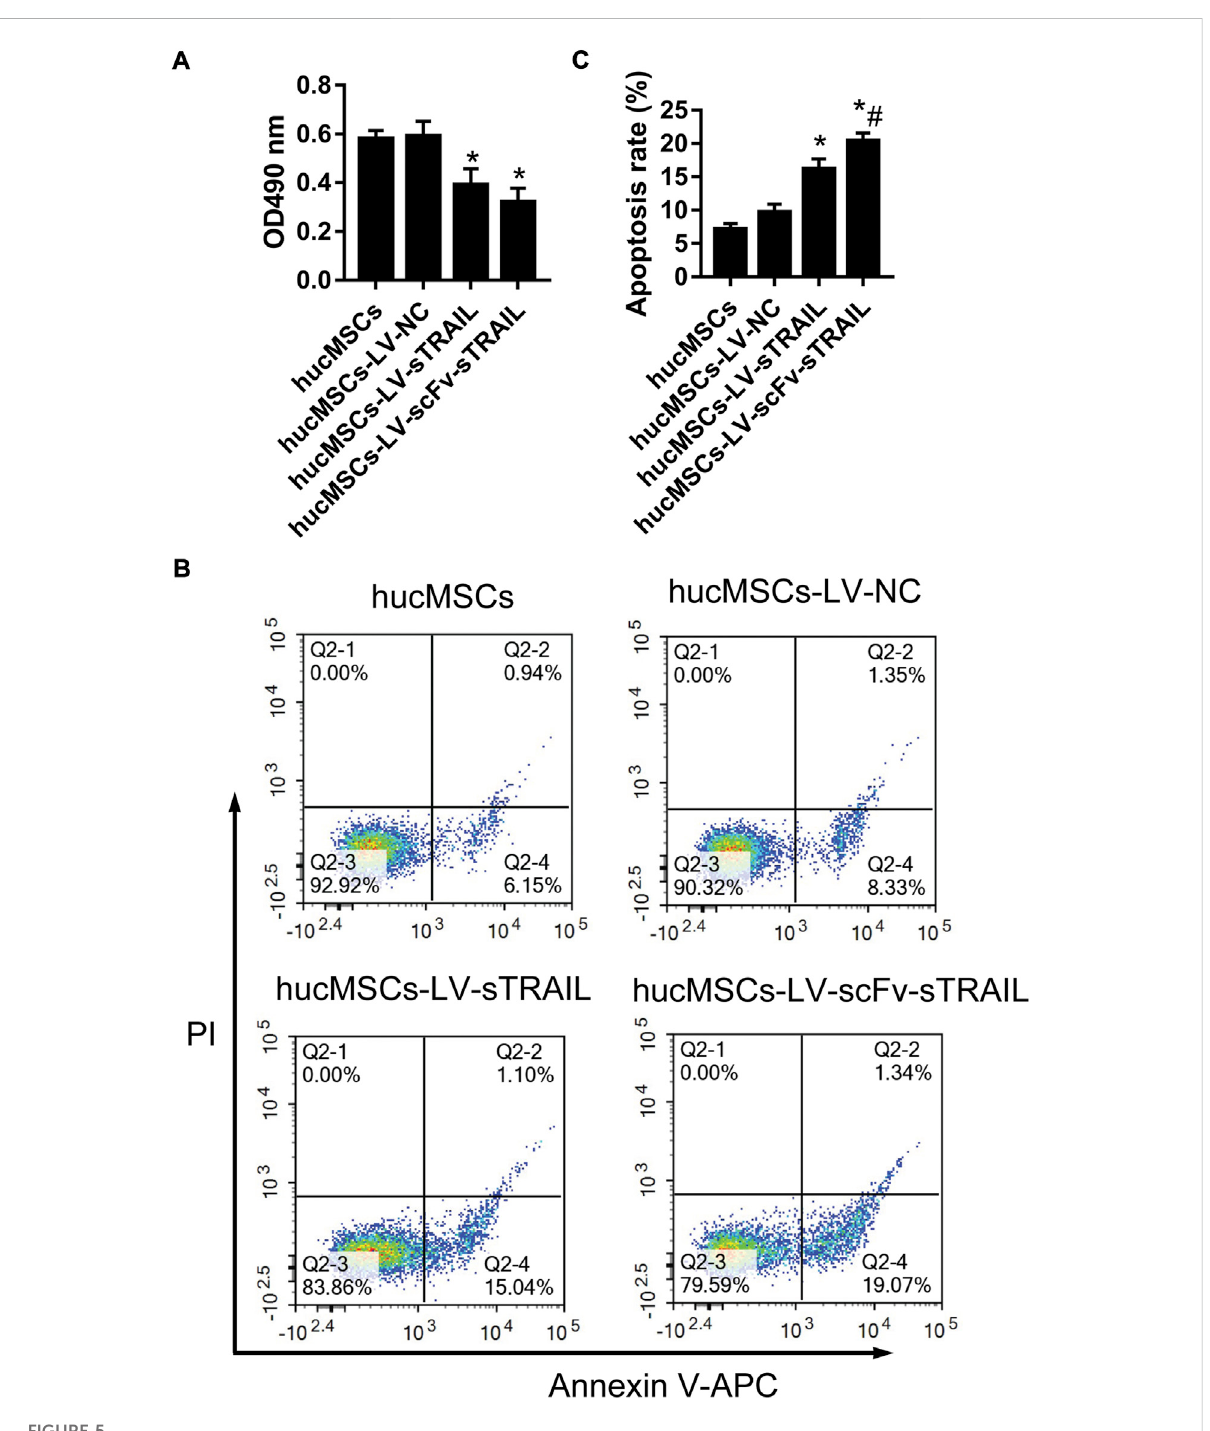
FIGURE 5 TheeffectofhucMSCsinfectedwithLV-scFv-sTRAILonproliferationandapoptosisofU87G. (A) TheproliferationofU87GmeasuredbyCCK-8 assay. (B) The apoptosis of U87G measured by fl ow cytometric analysis. (C) The quantitative data of cell apoptosis. n = 3, * p < 0.05 versus the hucMSCs-LV-NC group; # p < 0.05 versus the hucMSCs-LV-sTRAIL